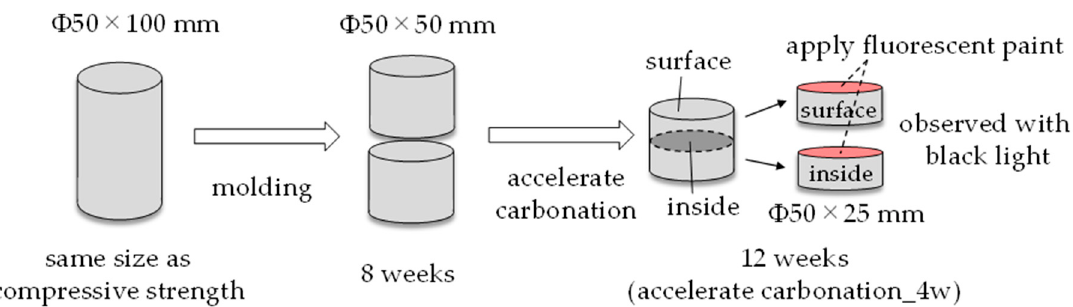
Figure 17. Method of the crack observation.